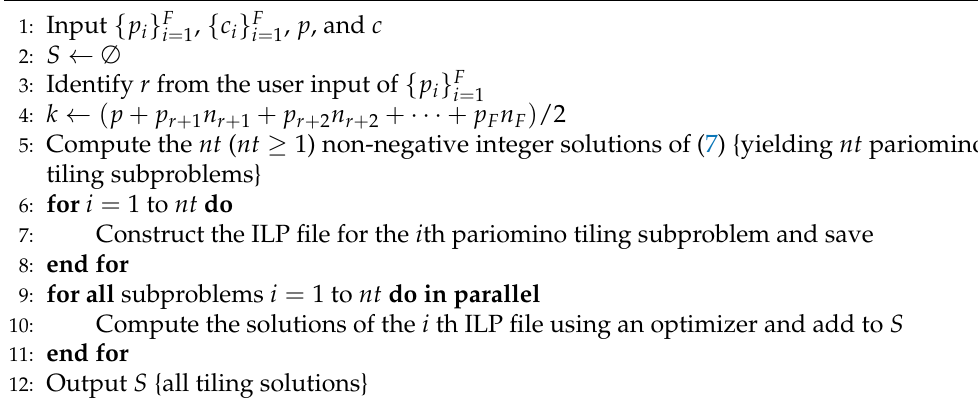
Algorithm 1 To find all possible solutions of a polyomino tiling problem using checkerboard colouring arguments and